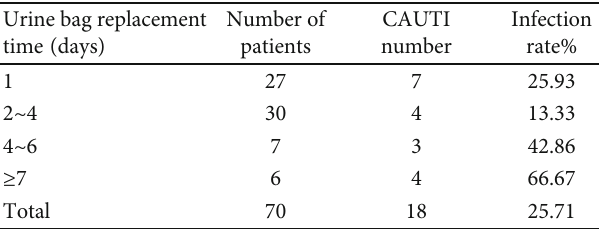
Table 2: In fl uence of changing time of urine collection bag on